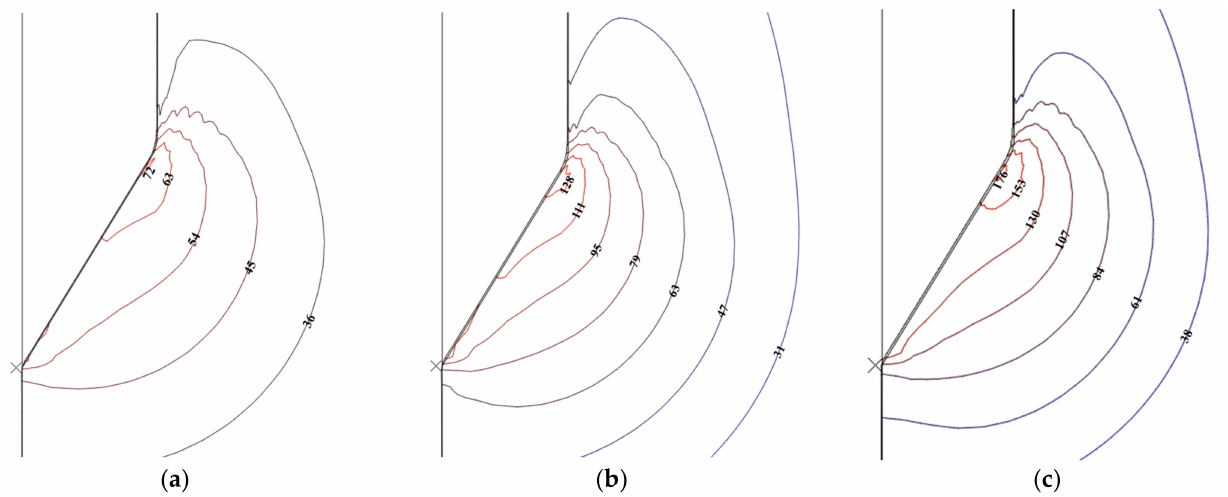
Figure 6. Computed ∆ u contours after penetration under different OCR at σ v = 30 kPa in kaolin silty clays. ( a ) OCR = 1; ( b ) OCR = 3; ( c ) OCR =